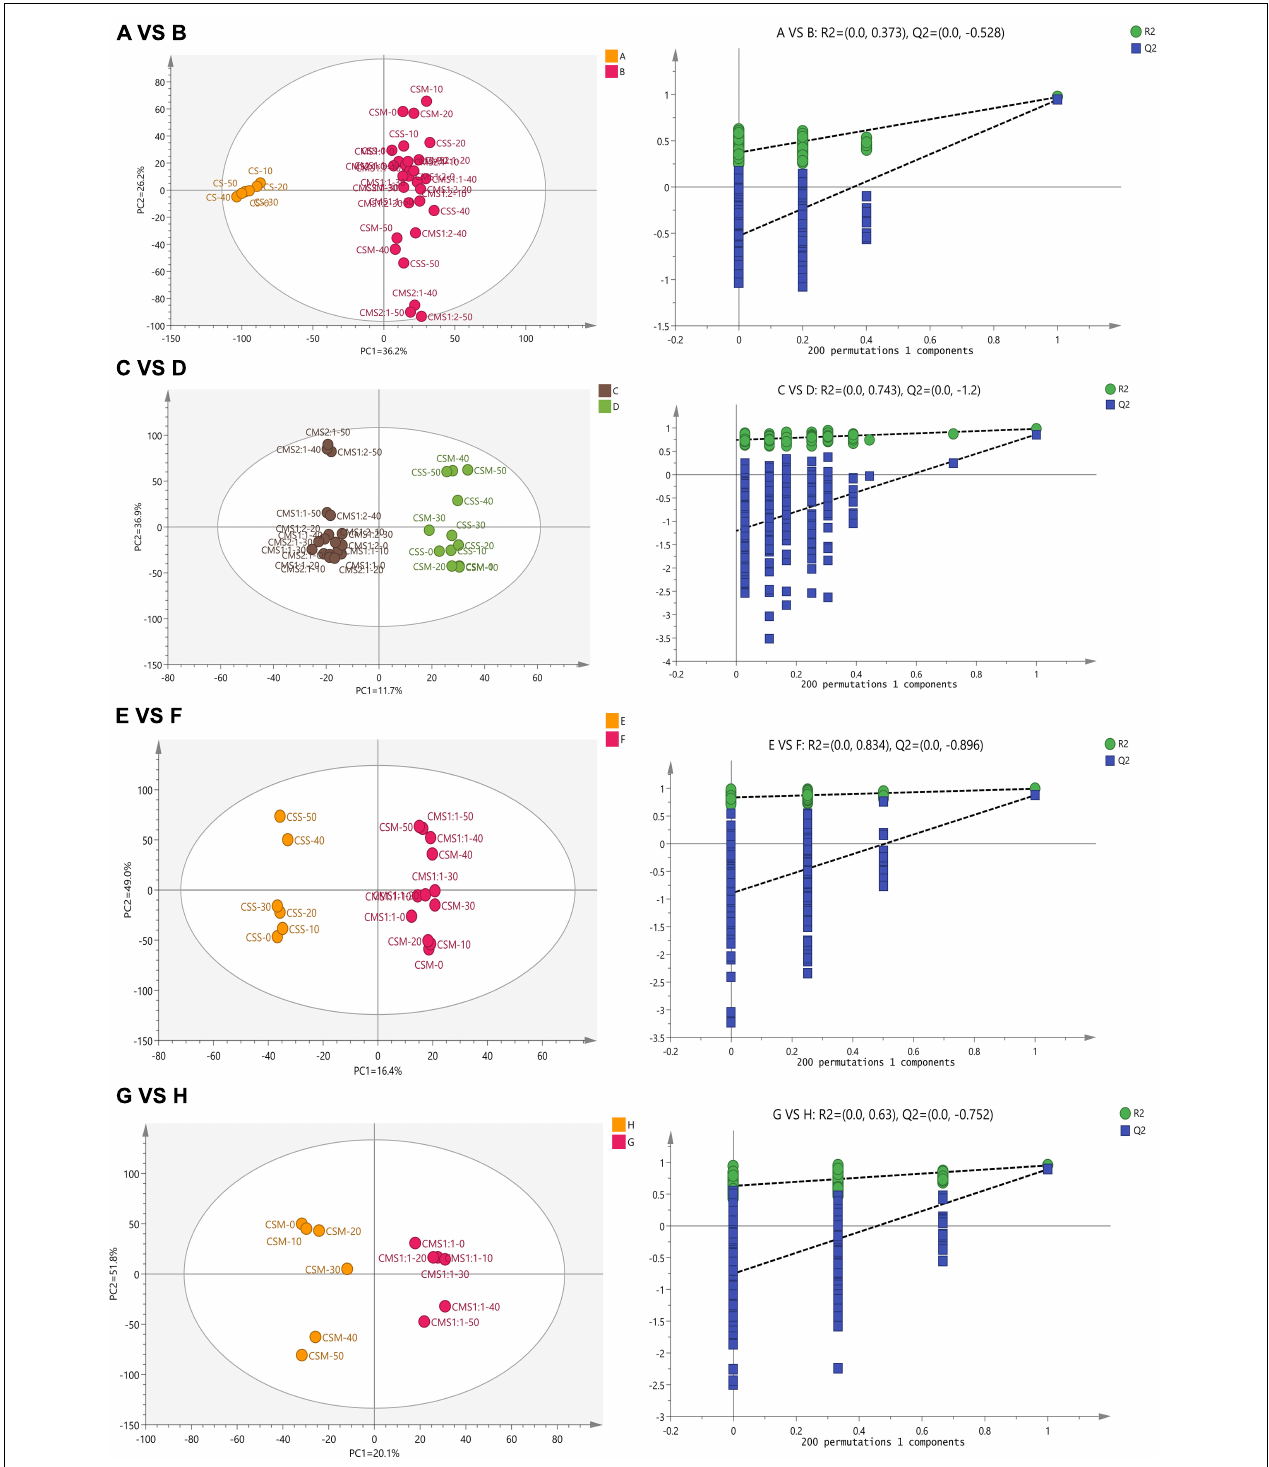
FIGURE 6 | Multivariate statistical analysis of flavor compounds in cheese during storage based on HCA. The results of discriminant analysis of group A versus group B, group C versus group D, group E versus group F, and group G versus group H from top to bottom. CS, CSM, CSS, CSM:CSS 1:1, CSM:CSS 1:2 and CSM:CSS 2:1 indicate the use of the commercial starter (Control group), K. marxianus B13–5, S. cerevisiae DL6–20, K. marxianus B13–5: S. cerevisiae DL6–20 1:1, K. marxianus B13–5: S. cerevisiae DL6–20 1: 2, and K. marxianus B13–5: S. cerevisiae DL6–20 2:1.